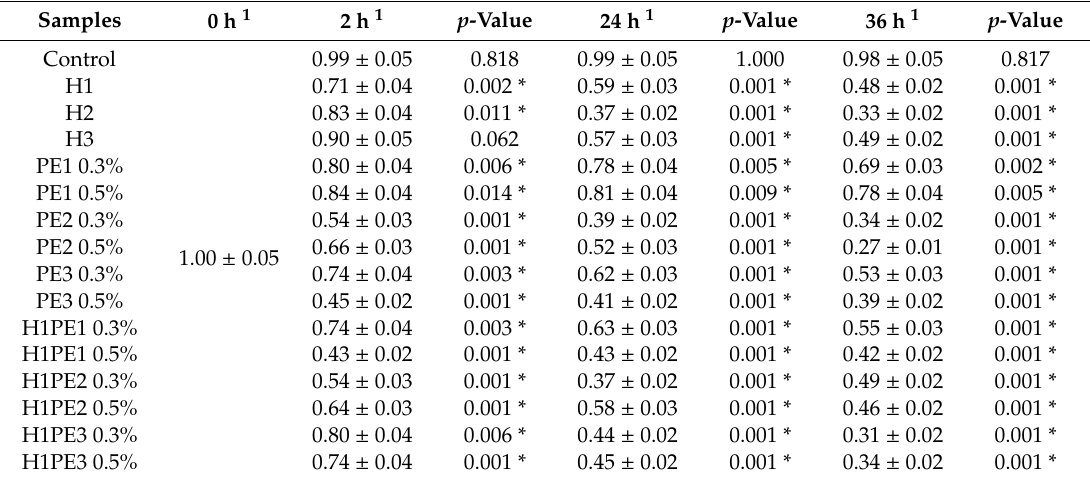
Table 6. Calculated distance between the margins of the